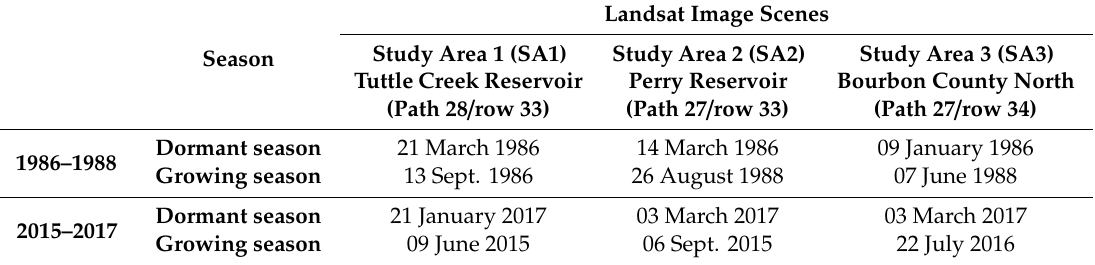
Table 1. Landsat scenes used in the